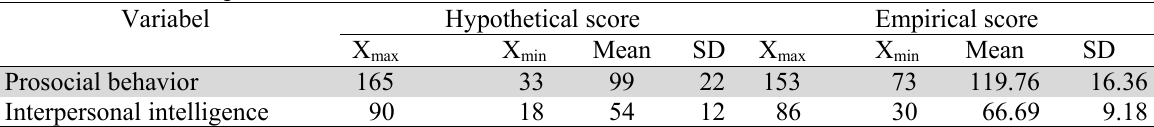
Research data description Variabel Hypothetical score